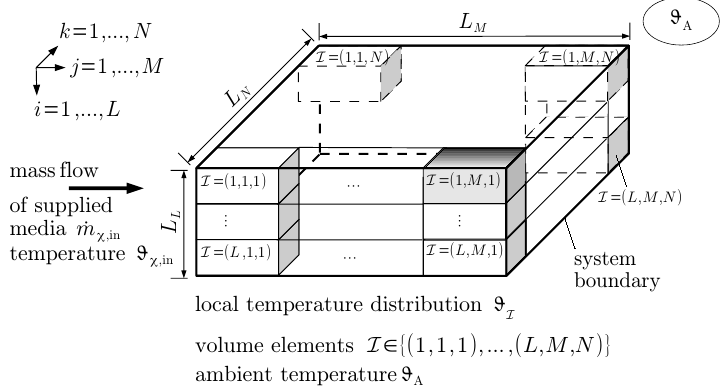
Figure 2. Spatial semi-discretization of the fuel cell stack